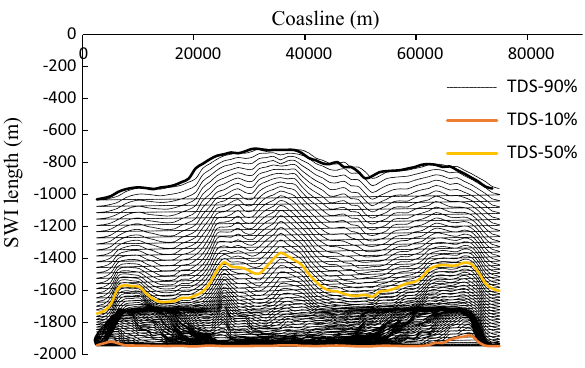
Fig. 12 Simulated TDS contour by SEAWAT